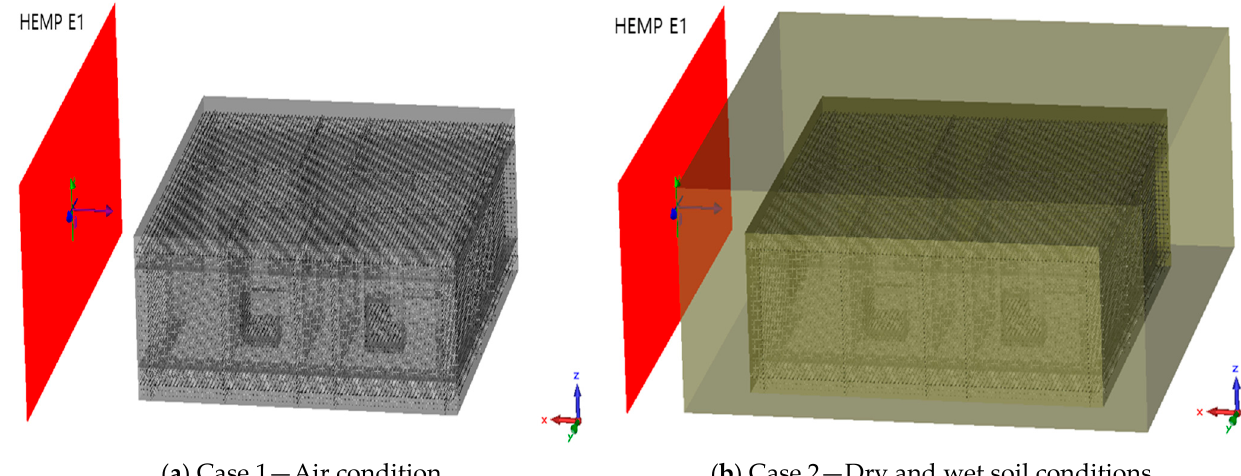
Figure 4. Simulation conditions ( a ) Case 1—Air condition, ( b ) Case 2—Dry and wet soil condi- tions.